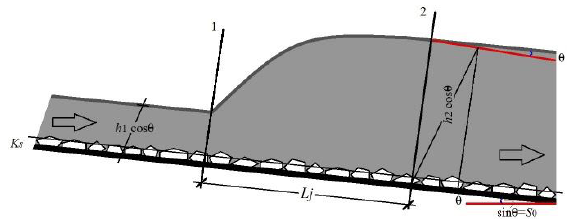
Figure 1. Schematic representation of hydraulic jump formation on rough sloping